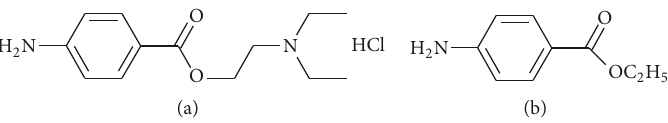
Figure 1: Structure formulas of procaine ( 1 ) and benzocaine